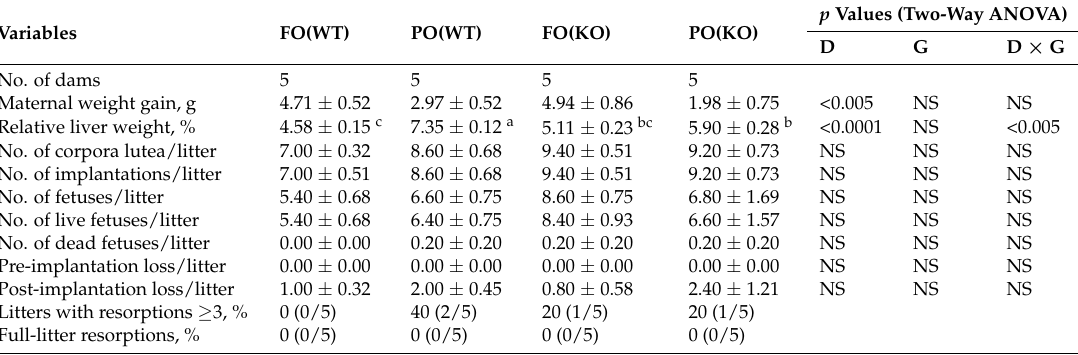
Table 2. Embryotoxicity and reproductive characteristics of the wild (WT) and peroxisome proliferator-activated receptor α (PPAR α ) knock out (KO) females receiving FO or PO diets during pregnancy 1,2 .